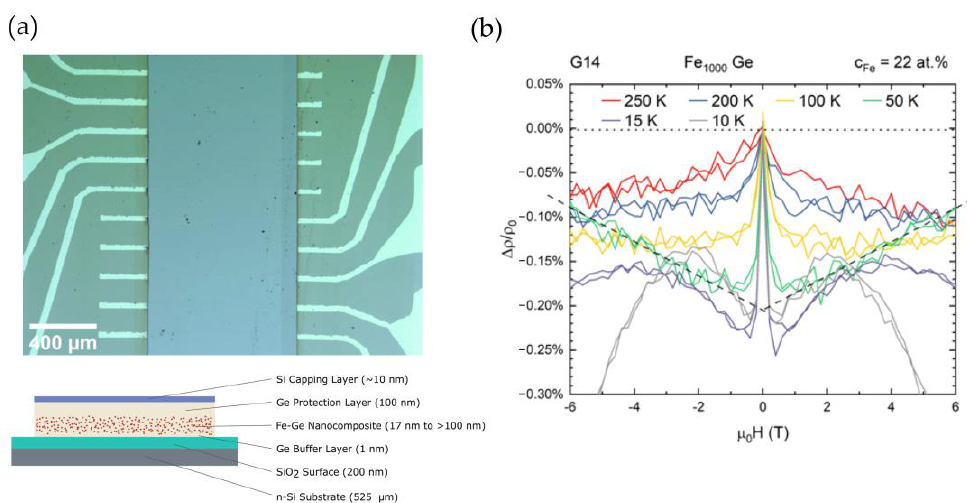
Figure 6. ( a ) Optical micrograph and schematic diagram of granular MR systems based on Fe nanoparticles in Ge matrix. ( b ) MR of Fe-Ge at different temperatures. Adapted from [ 75 ] . Figure Copyright © 2020 MDPI Publishing, Open Access.